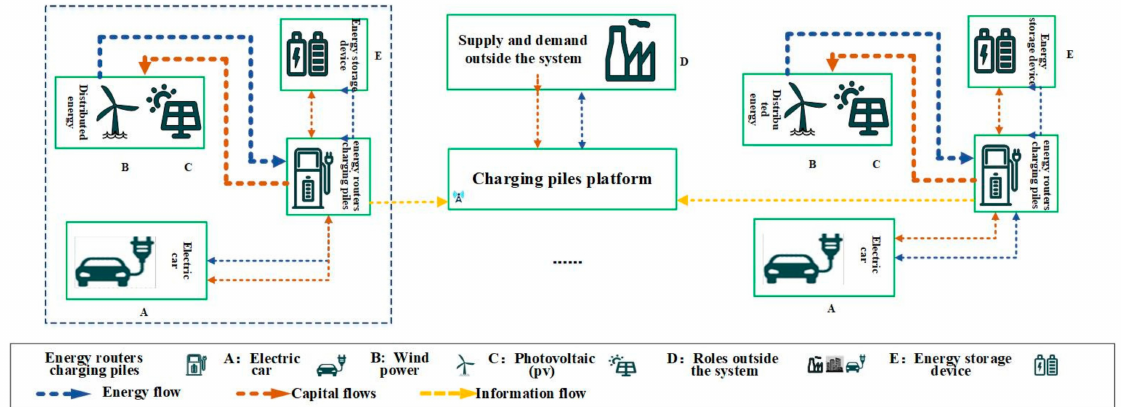
Figure 4. Multi-energy coupling scenario based on digital